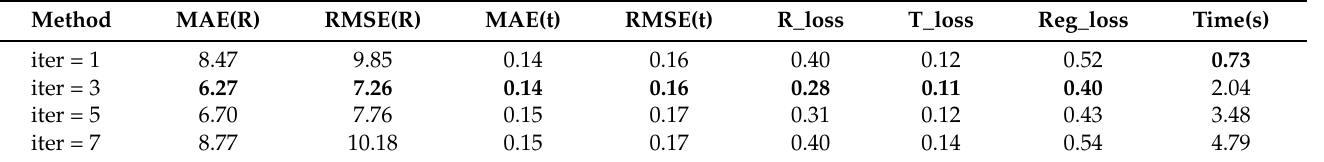
Table 6. Results on unseen categories point clouds in ModelNet40 under different iteration numbers. Bold numbers are the smallest in the current column, and represent the best